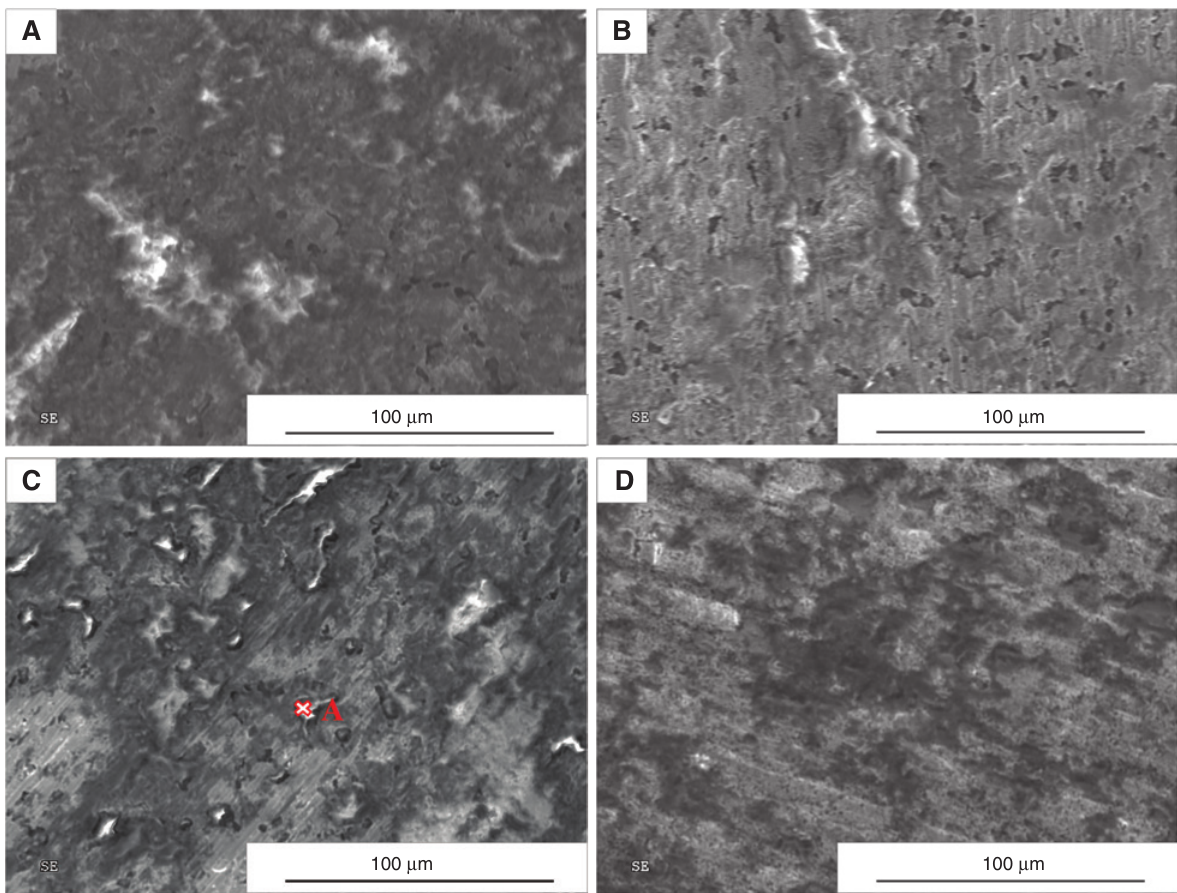
B C; (C) A B C; (D) A B 1 2 3 3 5 4